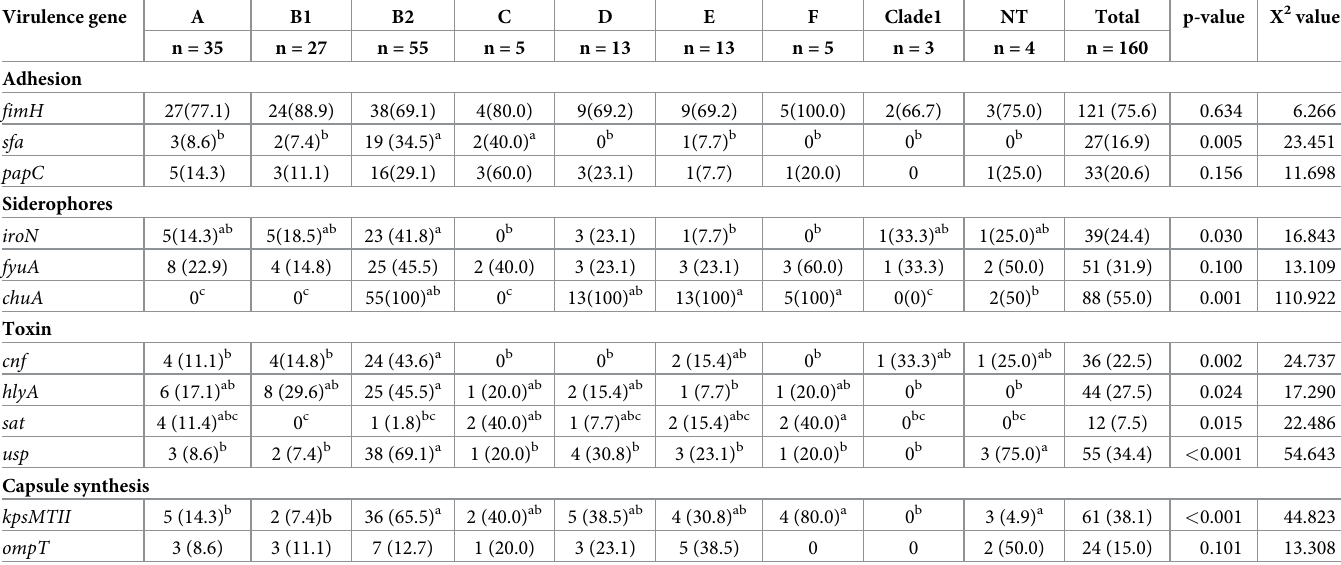
Table 3. Distributions of virulence genes among ASB E . coli isolates.